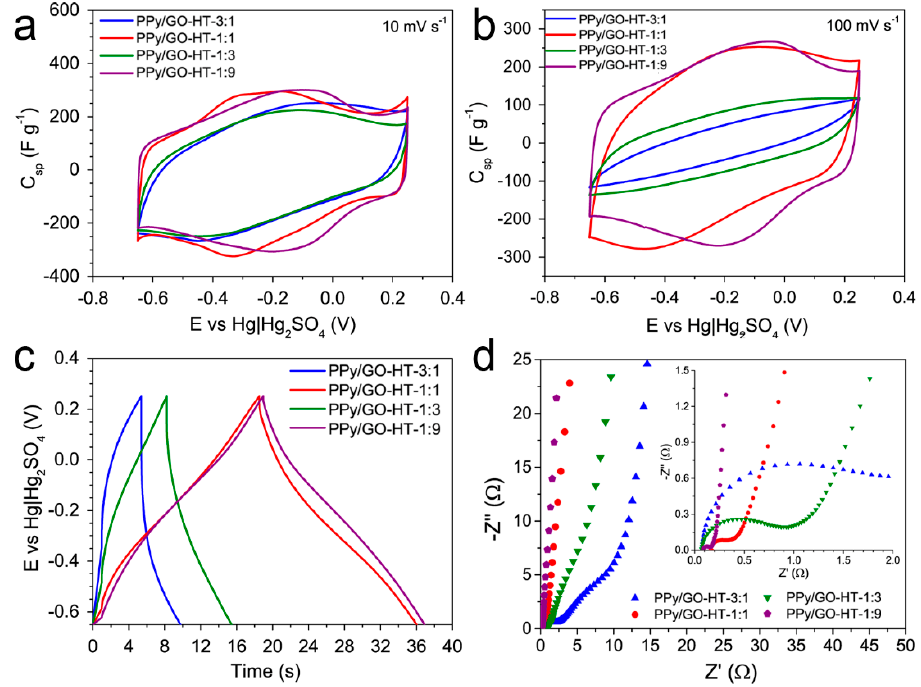
Figure 5. Electrochemical performance of PPy / GO-HT hybrids. Cyclic voltammetry (CV) curves at scan rates of ( a ) 10 mV s − 1 and ( b ) 100 mV s − 1 ; ( c ) galvanostatic charge–discharge profiles at a current density of 10 A g − 1 ; ( d ) Nyquist plots with an inset representing the high-frequency range.